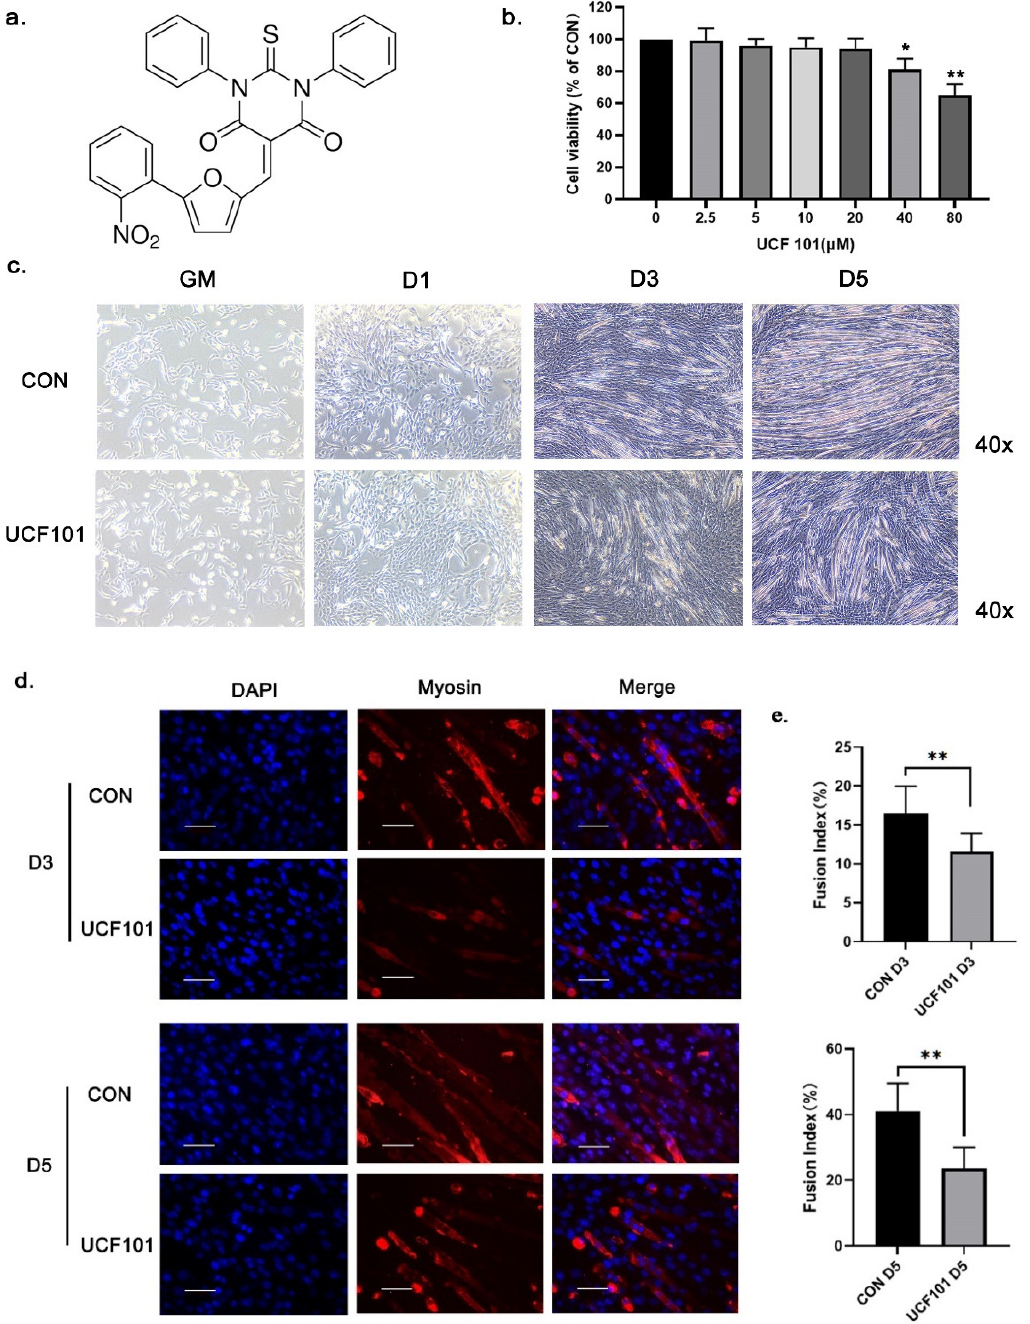
Figure 2. HtrA2/Omi protease deficiency impaired the differentiation of C2C12 myoblasts. ( a ) The chemical structure of UCF101. ( b ) Cells were treated with UCF101 for 48 h. The cell viability of C2C12 myoblasts was estimated by MTT assay. ( c ) Differentiation of C2C12 myoblasts treated with UCF101 (20 μM) or untreated on GM, D1, D3, and D5 at 40× magnification. ( d ) C2C12 myoblasts were treated with UCF101 (20 μM) or were untreated for 3 days and 5 days after differentiation. Immunofluorescence staining of Myosin (red) and the nucleus (blue) in C2C12 myoblasts (scale bar = 30 μm). ( e ) The FI of C2C12 myoblasts treated with UCF101 (20 μM) or untreated for 3 days and 5 days after differentiation. Fusion index (FI) was calculated as the percentage of total nuclei incorporated in myotubes. Two-tailed unpaired Student’s t -tests were used. Statistical significance: * p ≤ 0.05, ** p ≤ 0.01.